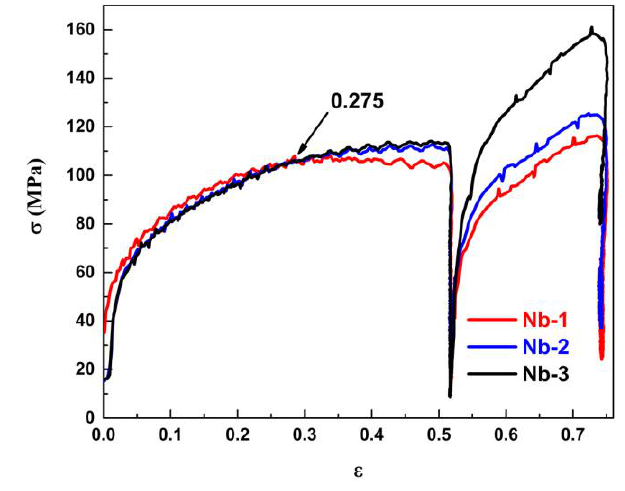
Figure 13. Stress-strain curve of double-pass rolling of tested steel.